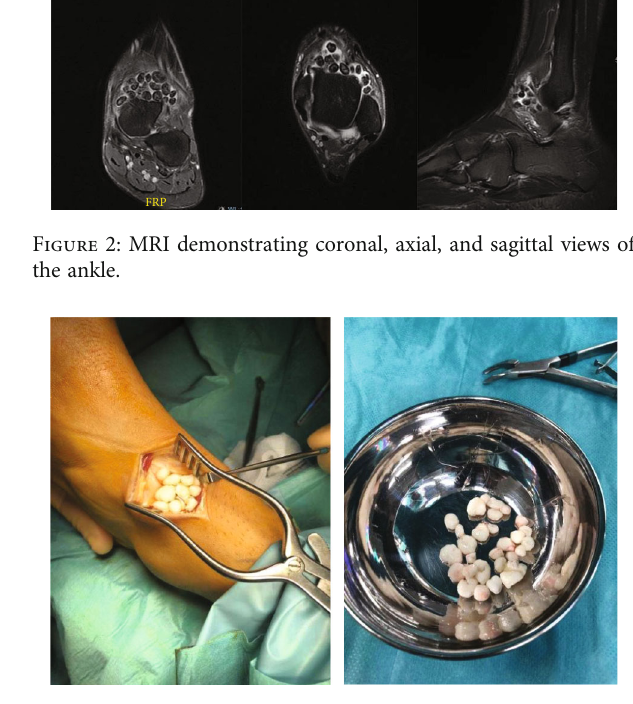
Figure 3: Intraoperative images of the ankle joint and the total amount of loose bodies removed.